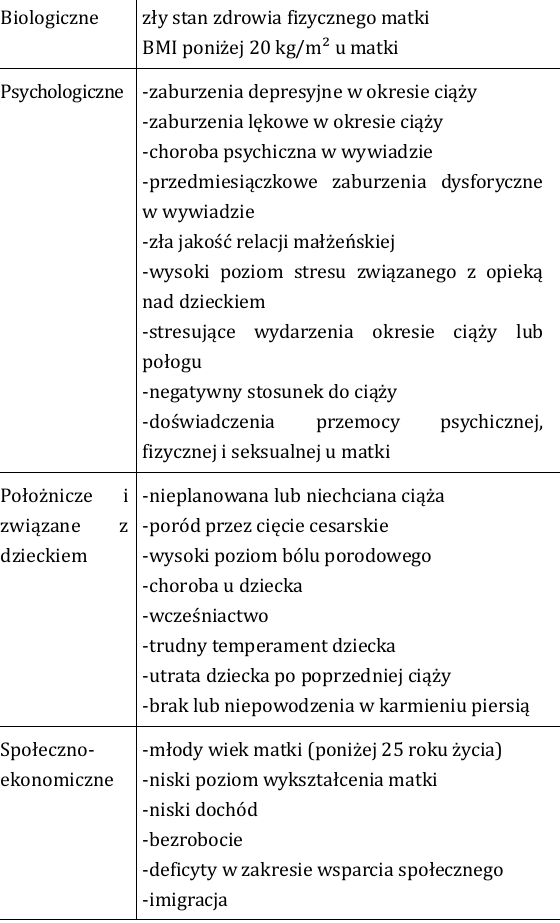
Tab.1. Czynniki ryzyka depresji